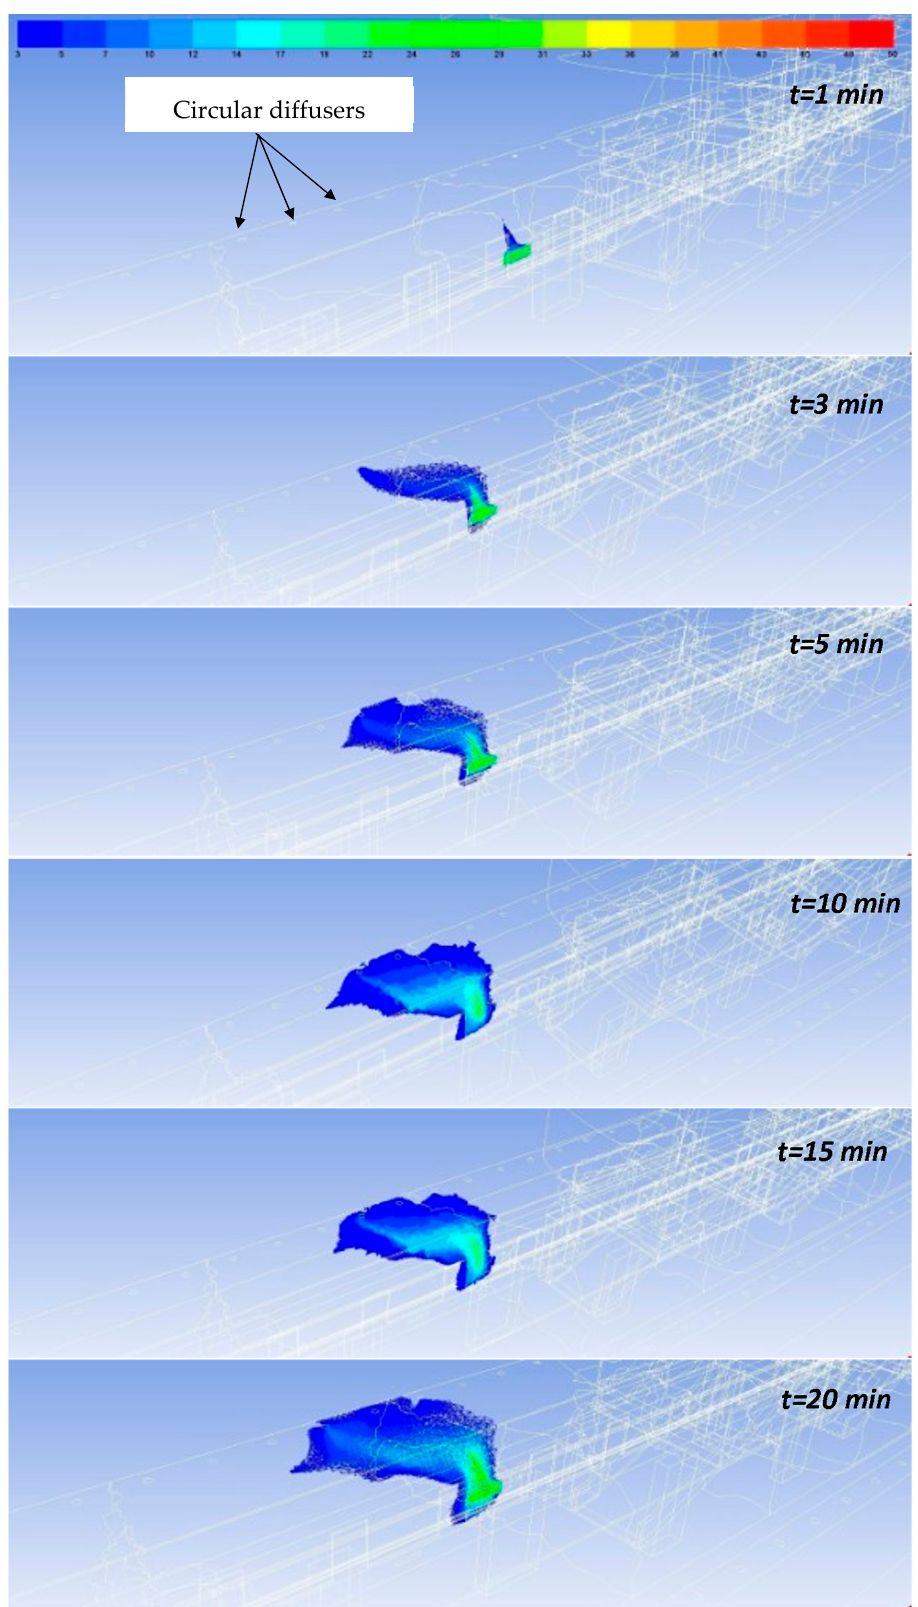
Figure 27. CO distribution (ppm)—area above the fire outbreak.